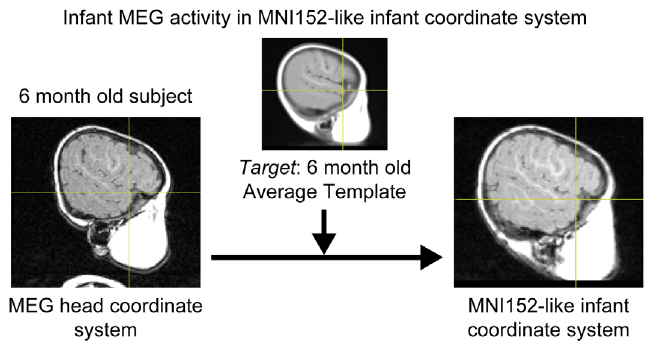
Figure 7. MEG coordinate space transformation . Estimated MEG activity location in a representative 6-month-old subject that has been successfully converted from the MEG subject-specific head coordinate system (left) to the standard iMNI infant coordinate system (right) by applying the appropriate transformation matrices.